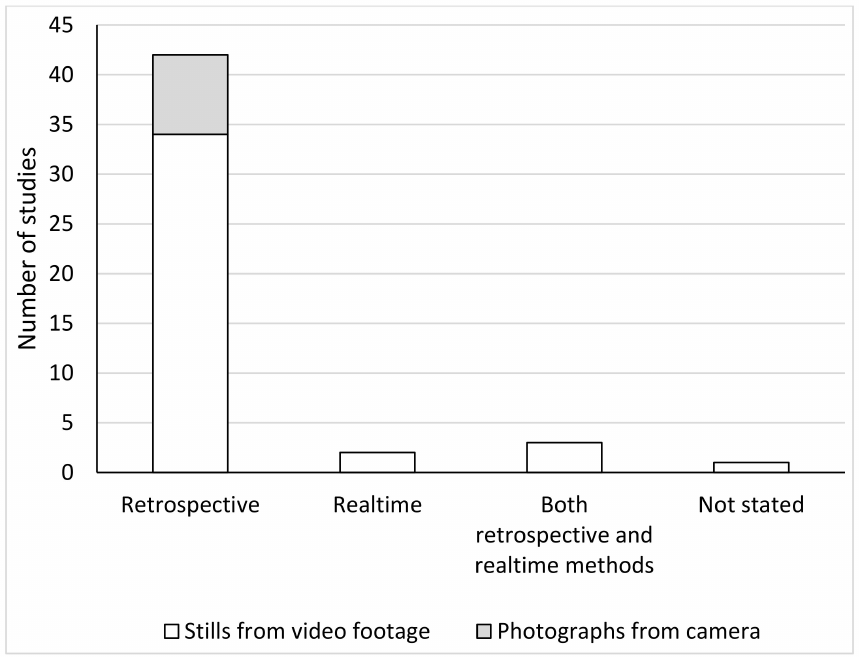
Figure 7. Collection methods used in included